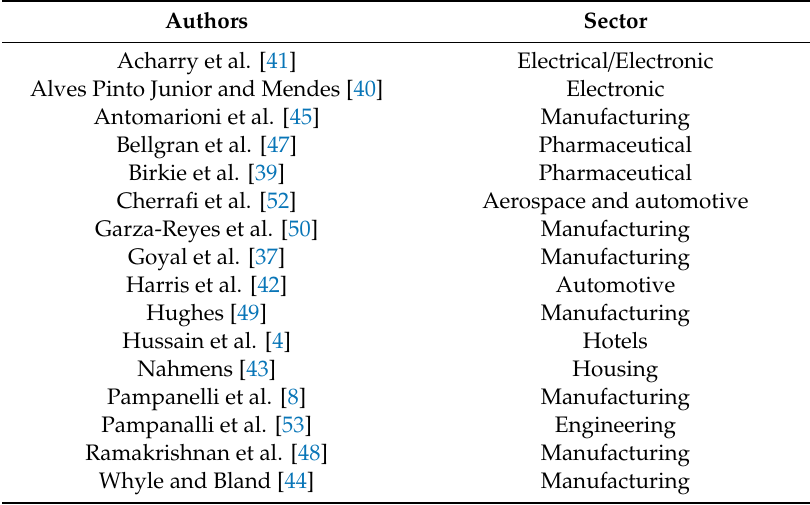
Table 6. Sector distribution.